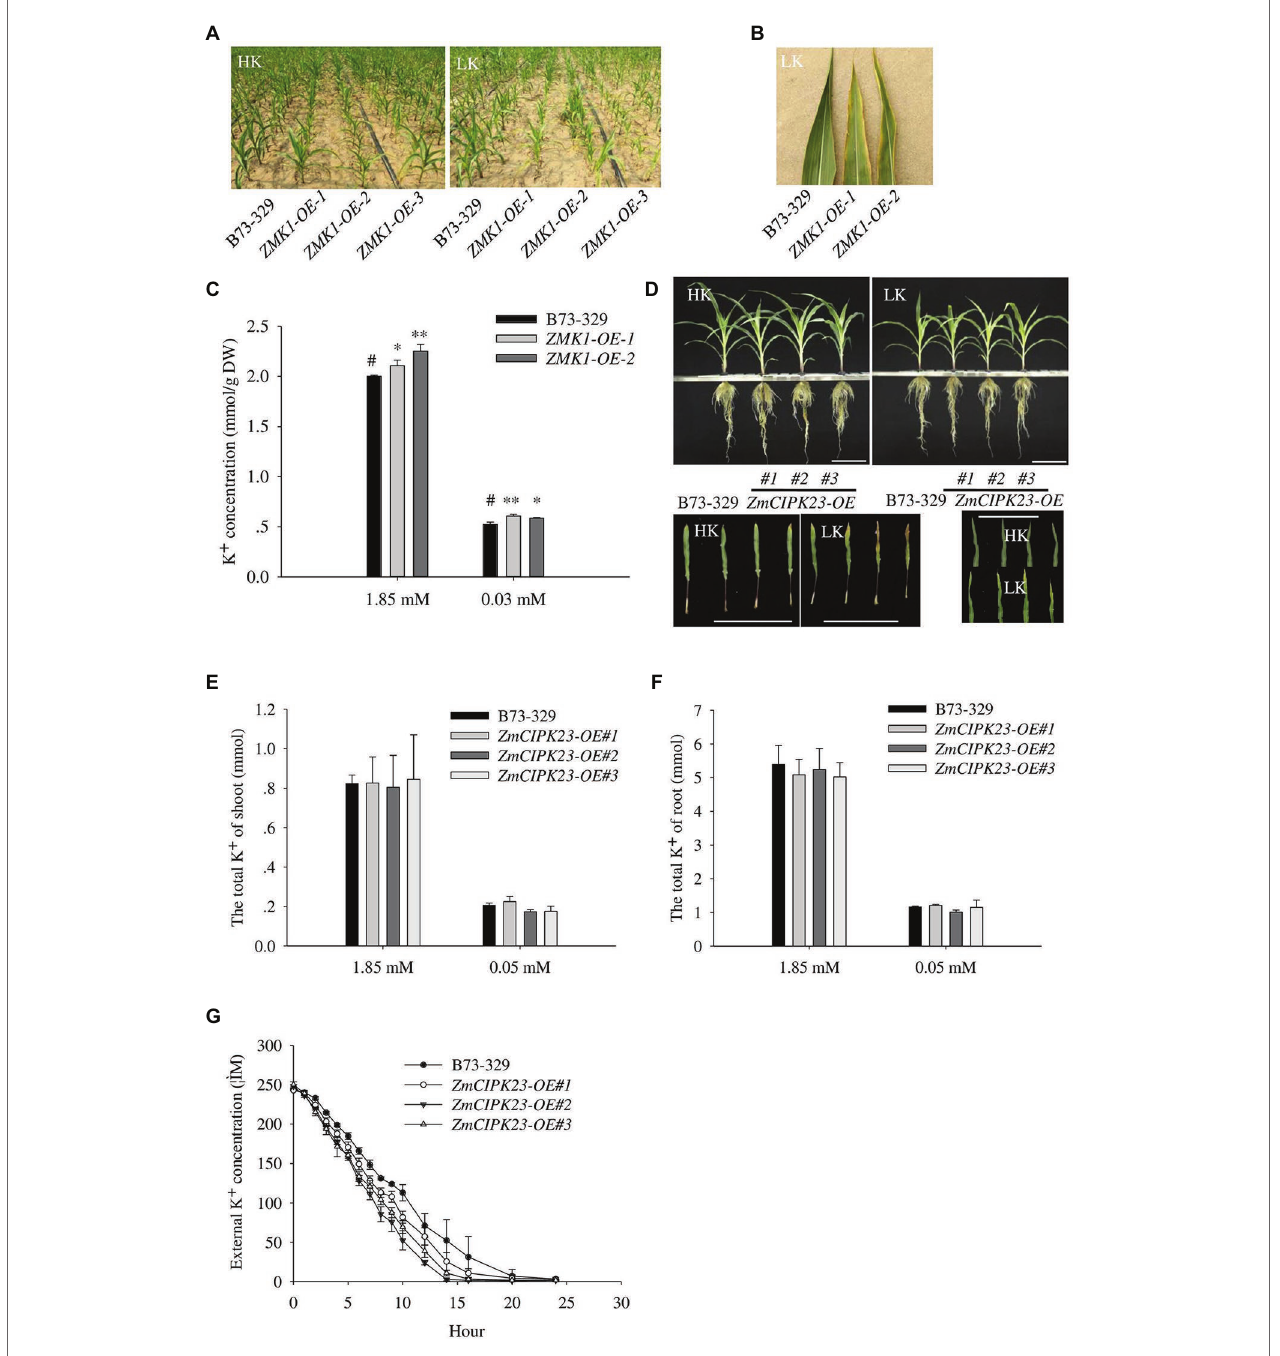
FIGURE 6 | Physiological function analysis of ZMK1 and ZmCIPK23. (A) Field phenotypic observation of ZMK1-OE in HK or LK fields. (B) Leaf phenotype observation in low potassium field. Plants were placed in the order B73-329, ZMK1-OE-1 , and ZMK1-OE-2 from left to right. Bars = 8 cm. (C) The K + concentration of B73-329 and ZMK1-OE plants (the whole plant) under HK or LK. The data are presented as means ± SE ( n = 5). Data are shown as means ± SE ( n = 5). Student’s t -test ( ∗ p < 0.05, ∗∗ p < 0.01) was used to analyze statistical significance and “ # ” represents the control. (D) Phenotypic comparison of control plants (B73- 329 inbred line), ZmCIPK23-OE plants under high K + (HK, 1.85 mmol/L) and low K + (LK, 0.05 mmol/L) conditions (top figure). Comparison the phenotypic of different leaves under high K + and low K + conditions. Plants were placed in the order B73-329, ZmCIPK23-OE#1 , ZmCIPK23-OE#2 , and ZmCIPK23-OE#3 plants (bottom figure). Photographs show maize seedlings grown in HK or LK hydroponic solution for 18 days. Bars = 15 cm. (E,F) The total K + of shoot or root in B73-329 or ZmCIPK23-OE plants. Data are shown as means ± SE ( n = 5). Student’s t -test ( ∗ p < 0.05, ∗∗ p < 0.01) was used to analyze statistical significance of differences between genotypes. The data are obtained from five biological replicates. (G) Comparison of K + uptake ability between B73-329 and ZmCIPK23-OE plants using the K + depletion method. Data are shown as means ± SE ( n = 3). The data are obtained from three biological